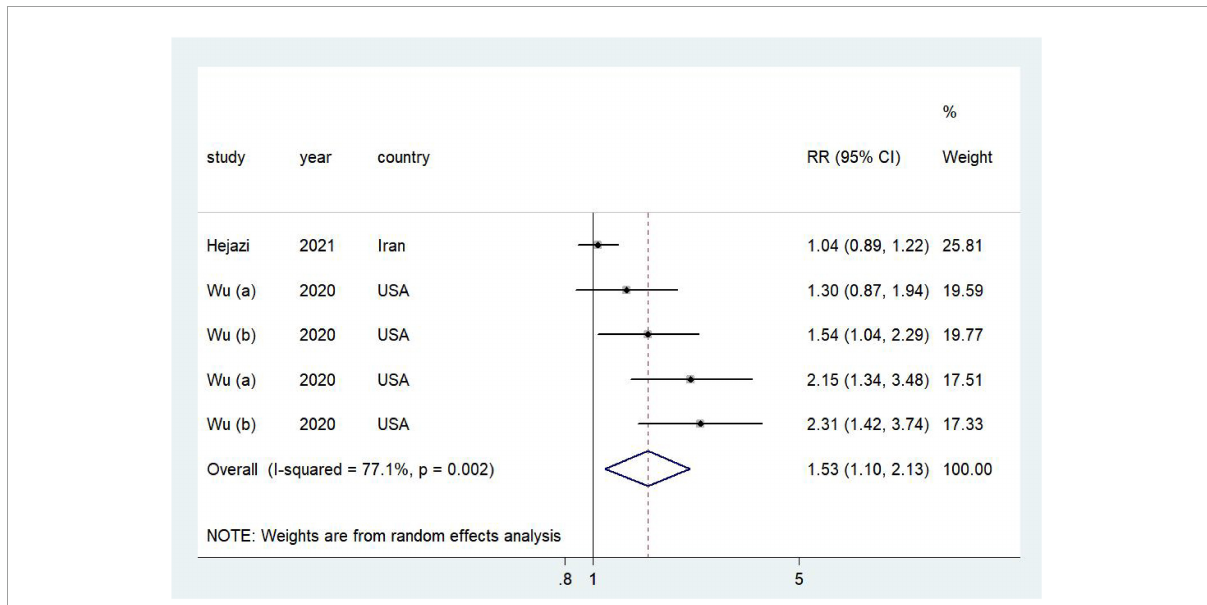
FIGURE3 Forest plot (a random-effects model) of the association between DAL and cancer prognosis (highest vs. lowest). Squares indicate study-specific relative risk (RR), where the size of the square reflects the study-specific statistical weight; horizontal lines indicate the 95% CI; and diamonds denote the summary RR with 95%